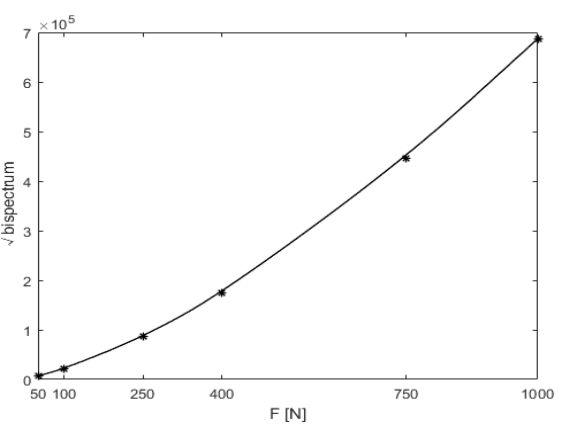
Figure 11. Variation trend of the second harmonic amplitude with the harmonic excitation magni- tude.